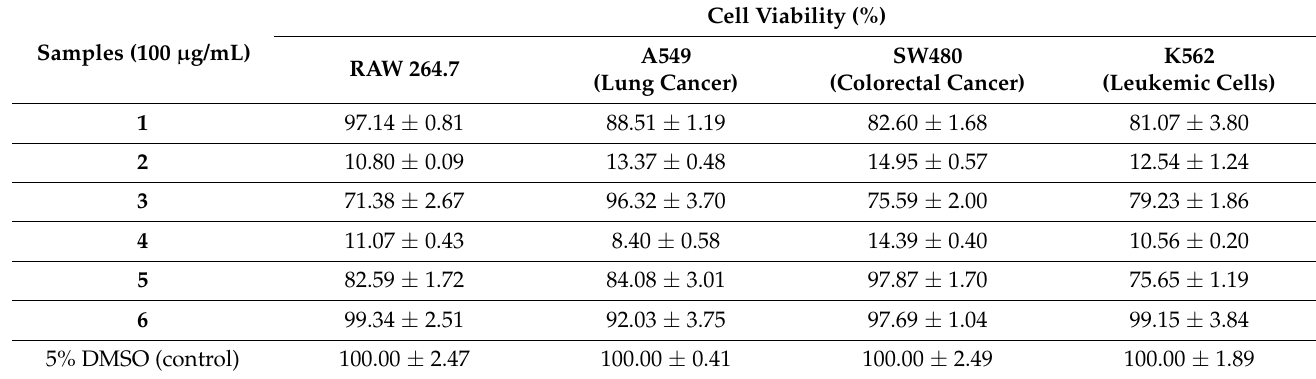
Table 2. Cell viability of compounds 1 – 6.